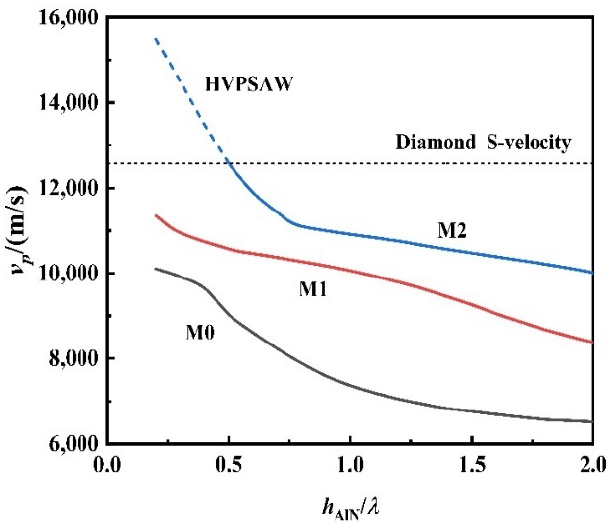
Figure 7. Curve characteristics of v p against h AlN / λ